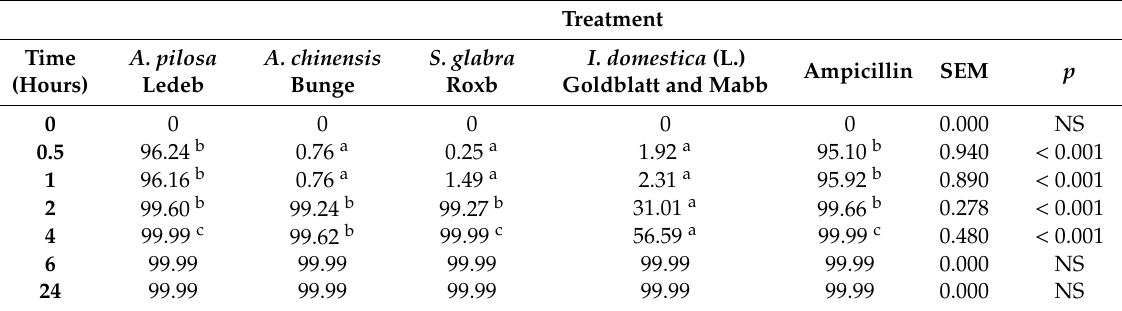
Table 3. Average percentage kill of E. coli ATCC 25922, UM004, UM011, and UM012 over 24 h in the presence of 4 × minimum inhibitory concentration (MIC) of plant extracts and ampicillin over 24 h. Treatment